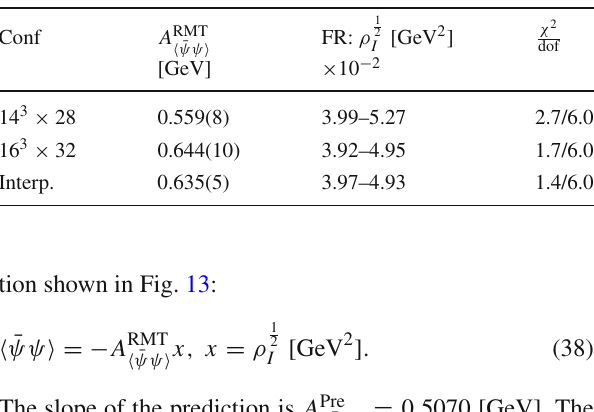
Figure 13 and the fitting results of the slope in Table 12 demonstrate that the renormalized chiral condensate that is calculated from the scale parameter (cid:12) decreases in direct proportion to the square root of the number density of the instantons and anti-instantons; however, the fitting results of the slope indicate that the effects of the finite lattice volume on the slope values appear and the interpolated results are not consistent with the prediction (36). Therefore, in the sections below, we improve the calculations of the observables by matching the numerical results with the experimental